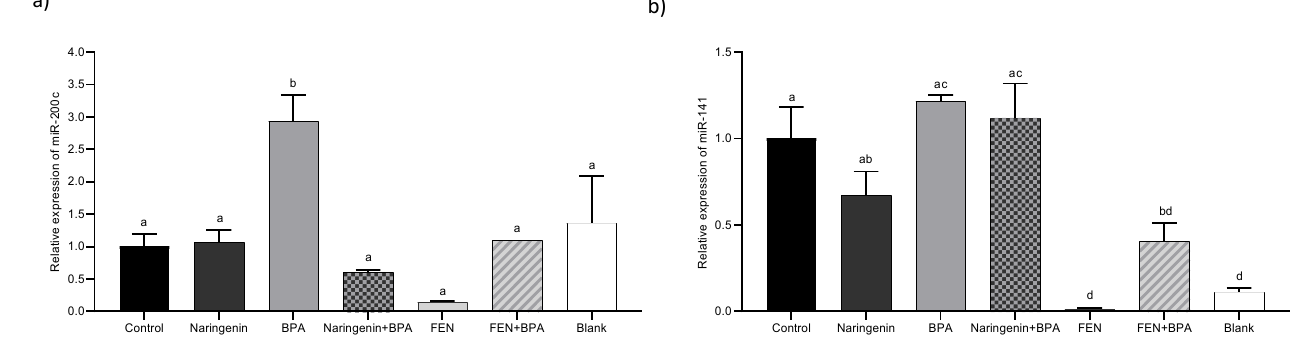
Figure 7. Relative miRNA expression; ( a ) miR-200c, ( b ) miR-141 relative to U6 in HT-29 cells treated with 250 µM naringenin, 4.4 µM BPA, 37% FEN, co-treatment naringenin + BPA or co-treatment FEN + BPA. The experimental data are expressed as the mean value ± SD of the two independent experiments. Letters indicate statistical difference by Tukey–Kramer’s Test ( p < 0.05).